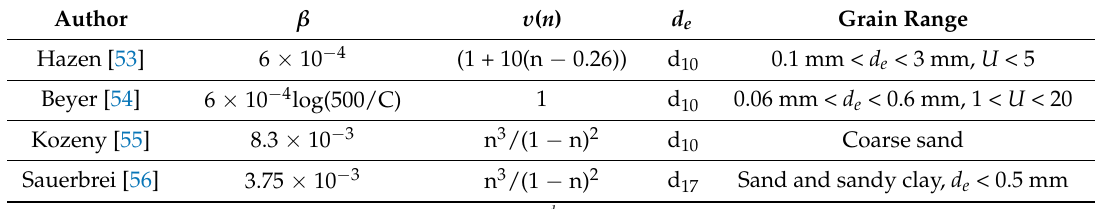
Table 4. The empirical formulas for the grain size